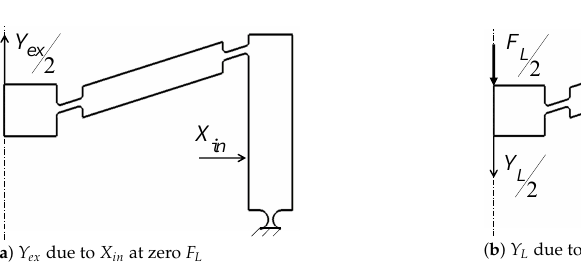
Figure 2. Output displacements Y ex and Y L